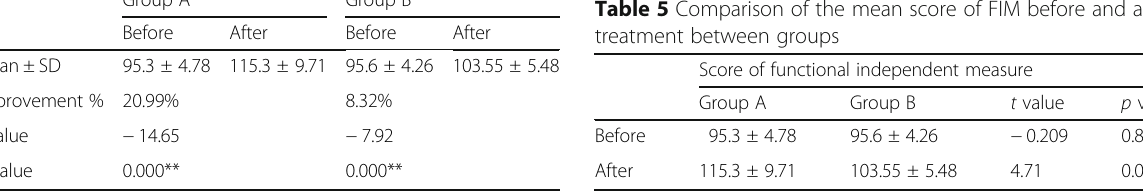
Table 4 Comparison of the mean score of FIM before and after treatment within each group Parameter